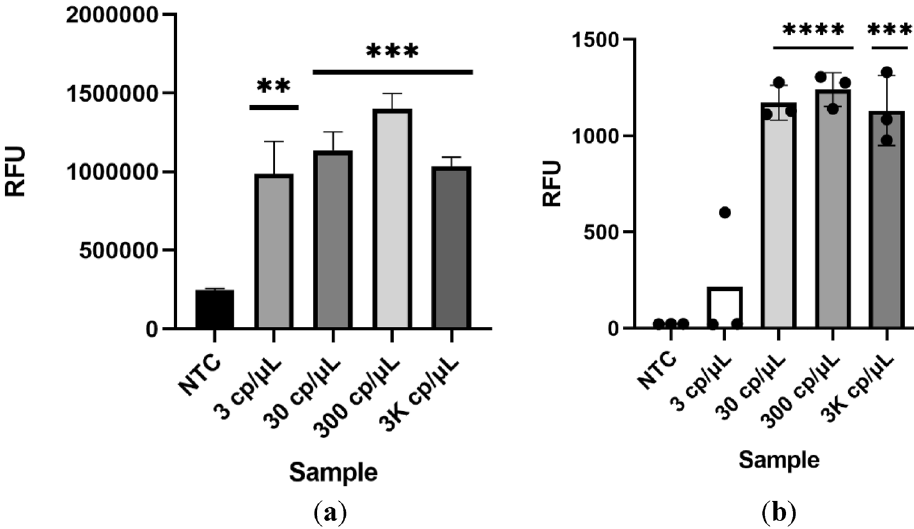
Figure 8. One-pot RT-LAMP-CRISPR/Cas12a detection of synthetic RNA. End point RFU signal using a dedicated equipment ( a ) after 10 min and Varioskan Lux multimode plate reader. ( b ) Statistical significance was determined by unpaired two-tailed t-test and all data were shown as mean ± S.D of 3 replicates. Asterisks indicate **P < 0.01; ***P < 0.001; ****P < 0.0001 and “ns” is